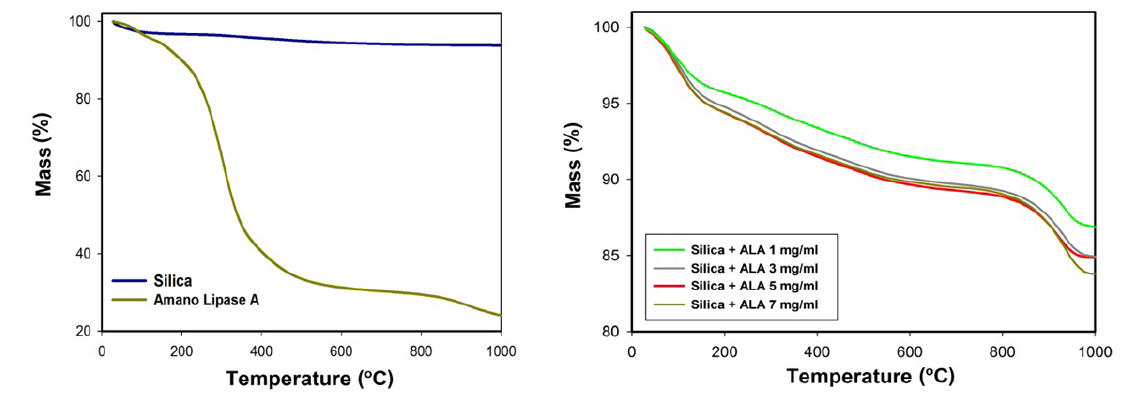
Figure 4: TG curves of the silica support and Amano Lipase A after